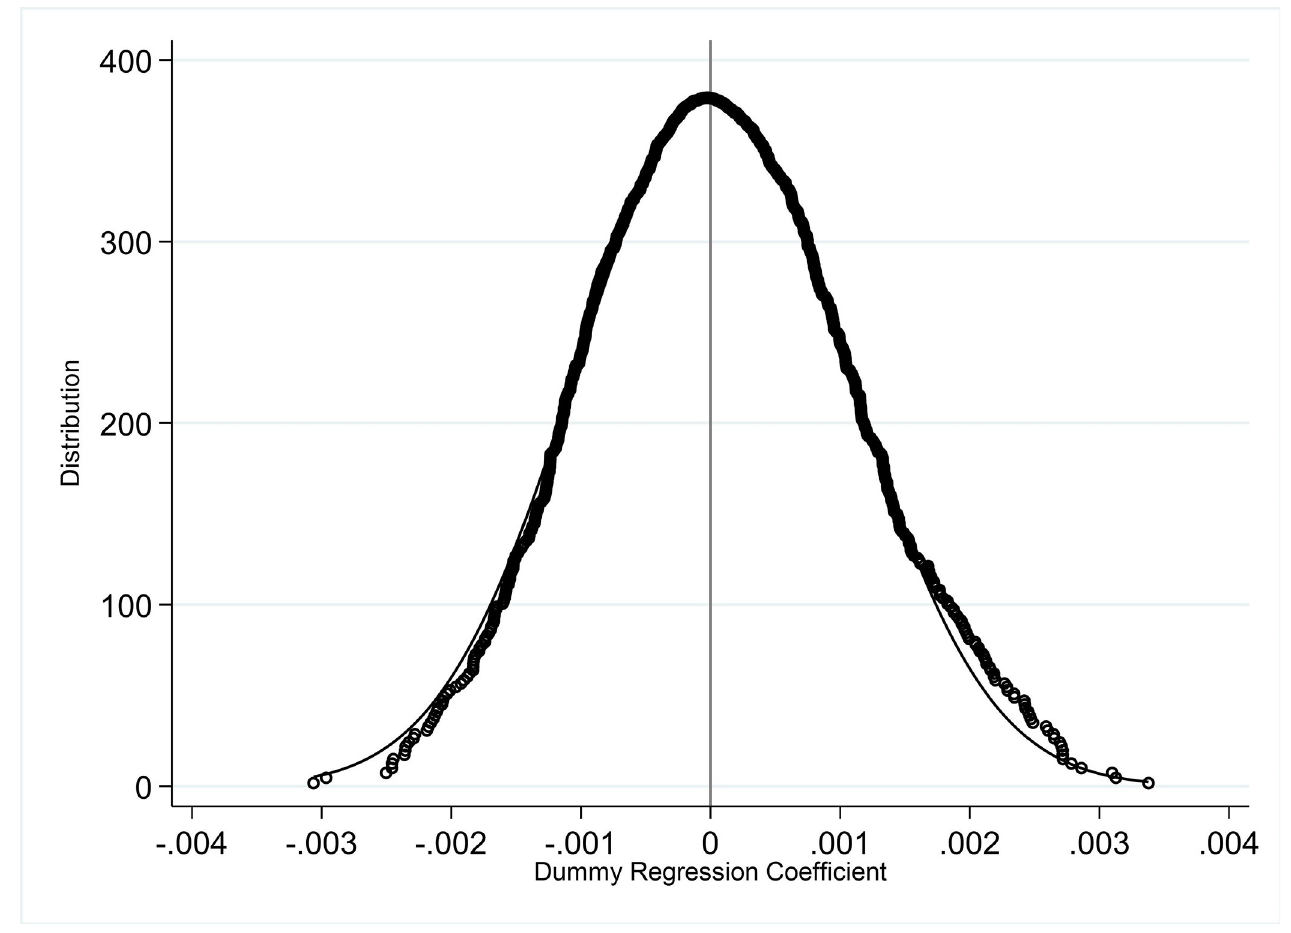
Fig 6. Non-parametric random simulation results. https://doi.org/10.1371/journal.pone.0274336.g006 Table 6. Tests on expected effects, expanding the scope of the pilot program, and other policy effects. Exclude the 2013 sample Exclude new pilot samples in 2015 Exclude samples from the three